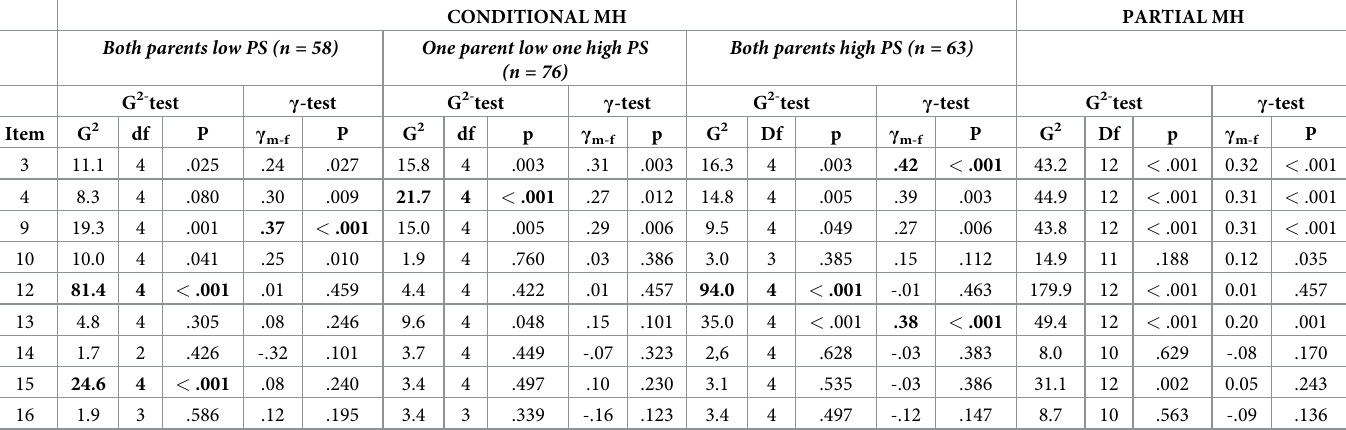
Table 6. Test for marginal homogeneity between mothers’ and fathers’ responses across parent couple stress